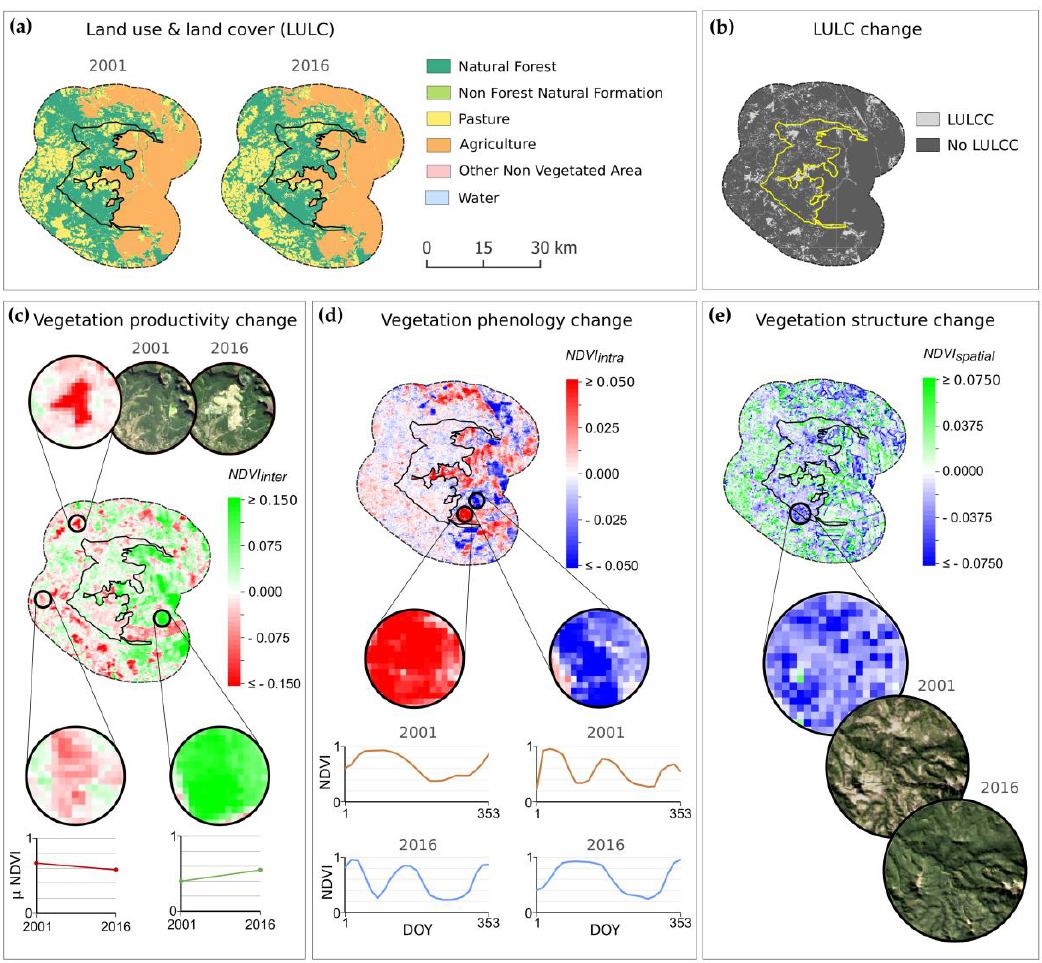
Figure 8. ( a ) Land use and land cover (LULC) in 2001 and 2016 at the Parque das Nascentes do Rio Taquari and its buffer zone; ( b ) LULC change map; ( c ) 𝑁𝐷𝑉𝐼 𝑖𝑛𝑡𝑒𝑟 results. Top zoom image: decrease in productivity due to forest clearing. Bottom-left zoom image: decrease in productivity in pasture area. Bottom-right zoom image: increase in productivity in agricultural area. Plots: average annual NDVI in 2001 and 2016 of one of the pixels inside the above pasture and agricultural areas; ( d ) 𝑁𝐷𝑉𝐼 𝑖𝑛𝑡𝑟𝑎 results. Left zoom image: increase in intra-annual variability in agricultural area due to the increase in the number of crop cycles during the year. Right zoom image: opposite dynamic. Plots: profile of NDVI against the day-of-year (DOY) in 2001 and 2016 of one of the pixels inside the agricultural areas in the above zoom images; ( e ) NDVI spatial results. Zoom image: decrease in spatial variability reflecting densification of forest